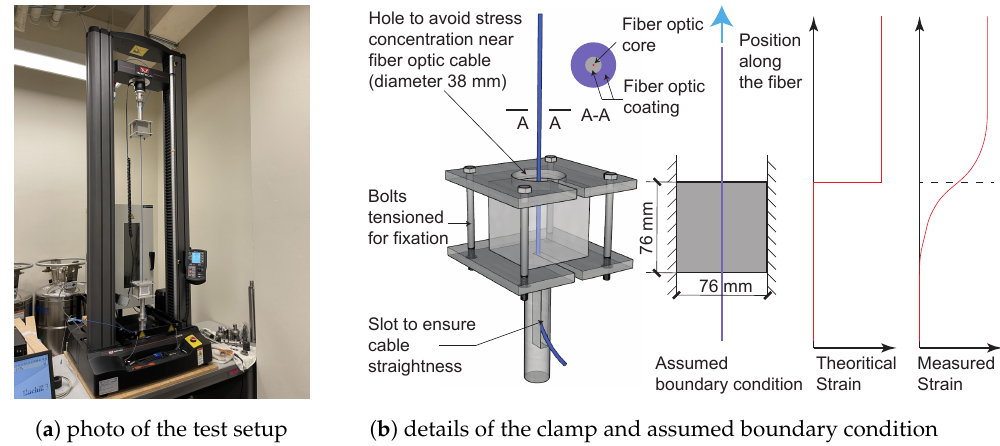
Figure 3. Photos of the calibration rig and details of the